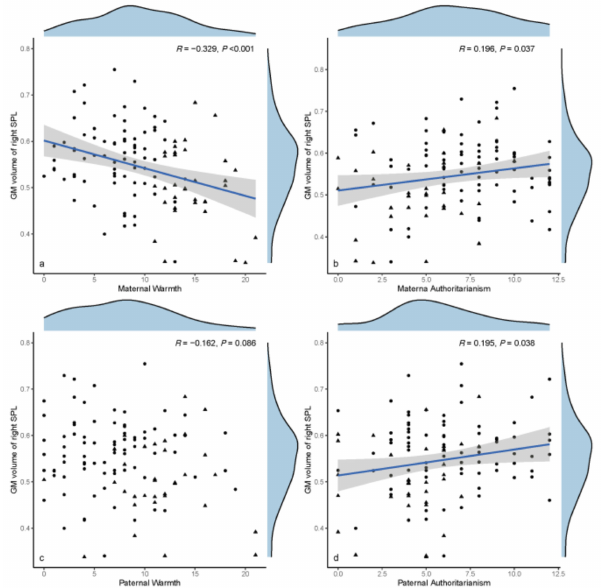
Figure 5. A negative correlation between the GMV of the ROI and maternal warmth scores ( r = − 0.329, p < 0.001) and a positive correlation between the GMV of the ROI and parental authoritarianism scores (for mother: r = 0.196, p = 0.037; for father: r = 0.195, p = 0.038) were observed. The GMV of the ROI is negatively correlated to maternal warmth scores ( r = − 0.329, p < 0.001) ( a ). The GMV of the ROI is positively correlated to maternal authoritarianism scores ( r = 0.196, p = 0.037) ( b ). There is no significant correlation between the GMV of the ROI and paternal warmth ( c ). The GMV of the ROI is positively correlated to paternal authoritarianism scores ( r = 0.195, p = 0.038) ( d ). The triangle represents the AP group and the circle represents the OP group. The density curves represent the distribution of the